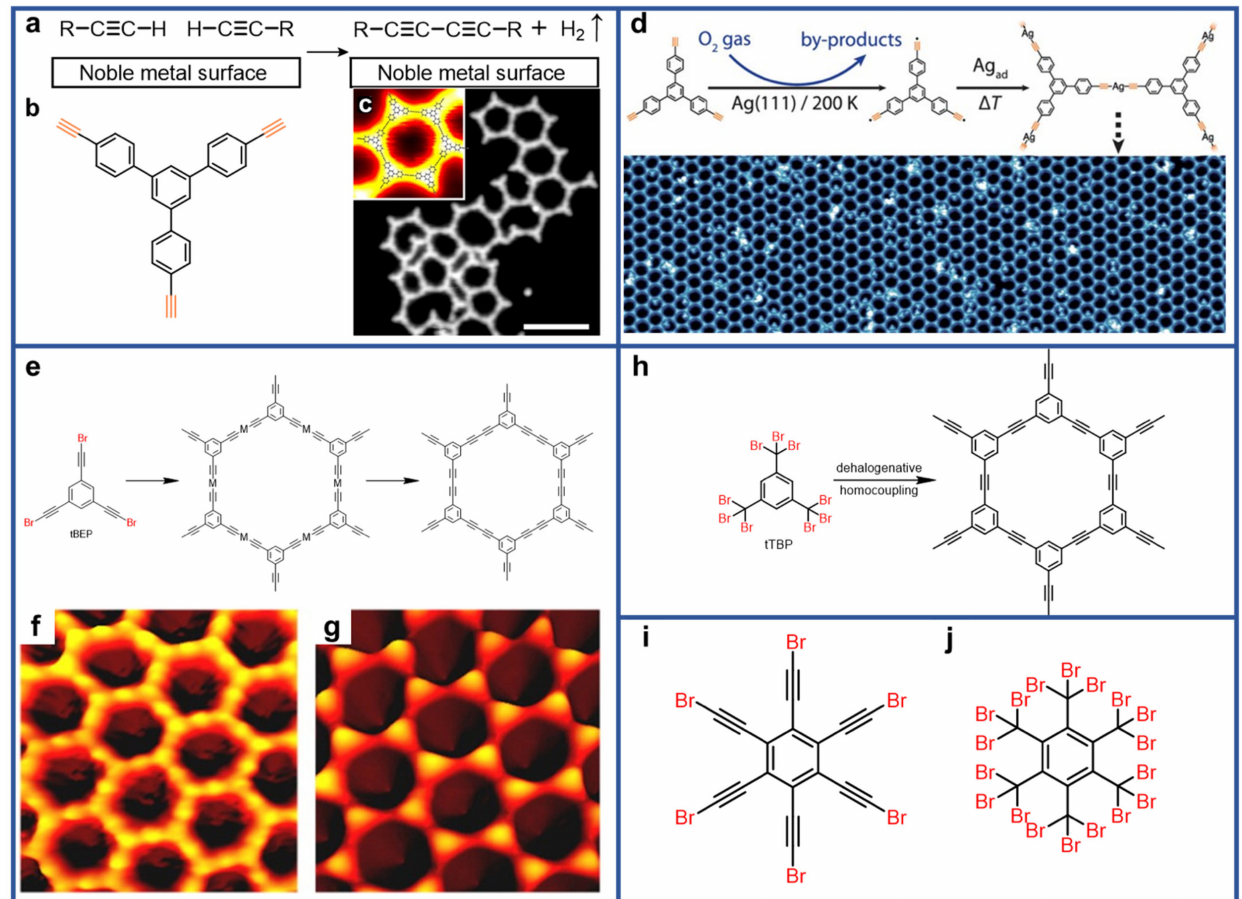
Figure 5. ( a ) Scheme of surface-assisted Glaser homocoupling reaction. ( b ) Chemical structure